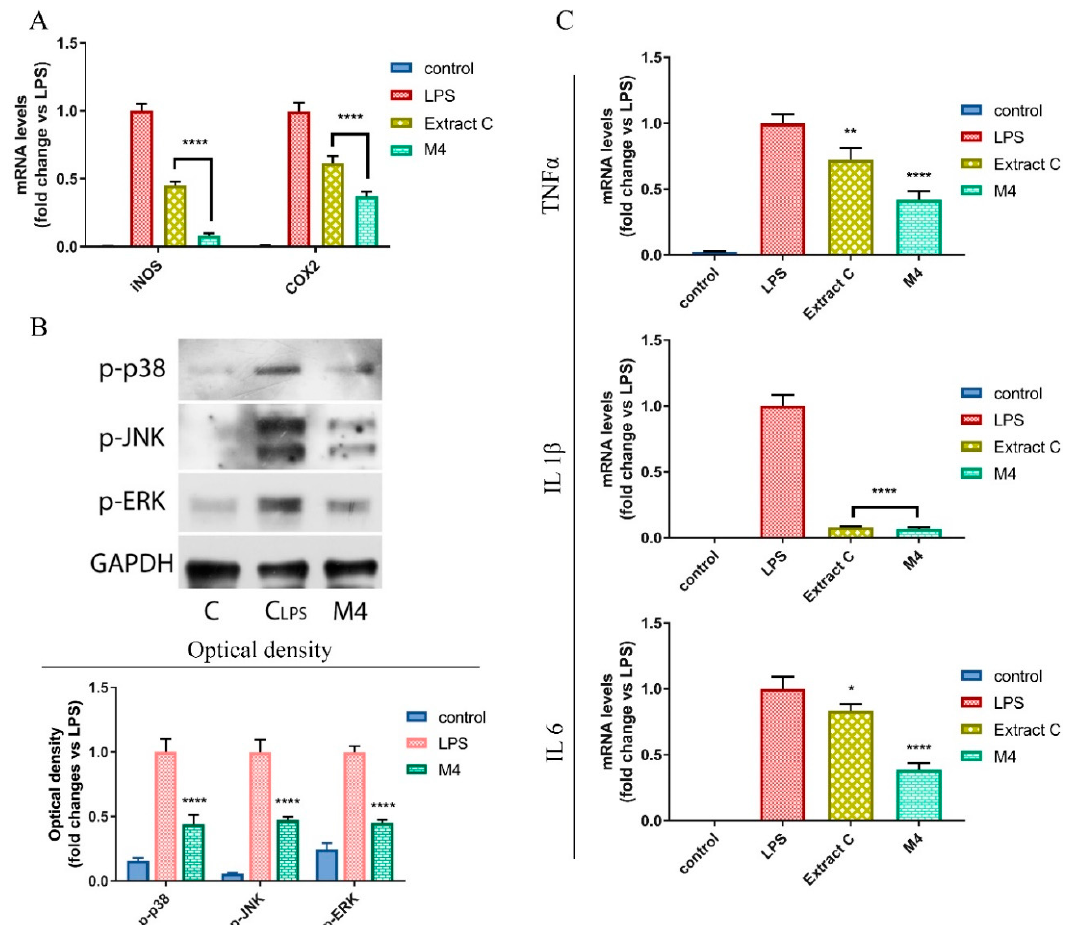
Figure 6. Licoflavanone (M4), as well as the phytocomplex from which it was isolated (extract C), disrupts mitogen-activated protein kinases (MAPK) / NF-kB pathway and modulates pro-inflammatory cytokines in RAW 264.7 cells. ( A ) E ff ects of extract C and M4 (both used at their IC 50 values) on inducible nitroxide synthase (iNOS) and cyclooxygenase 2 (COX2) mRNA levels. ( B ) Immunoblotting analysis of phosphorylated MAPKs (p-p38, p-JNK and p-ERK) and relative quantification of expression levels. Glyceraldehyde 3-phosphate dehydrogenase (GAPDH) was used as loading control ( C ) E ff ects of treatments on pro-inflammatory cytokines (Tumor Necrosis Factor alpha (TNF α ), Interleukin-1 beta (IL 1 β ) and Interleukin-6 (IL 6)) mRNA levels. Treatment conditions for the di ff erent experiments are reported in the Methods (Sections 2.11 and 2.12). Values represent mean ± S.D. of three independent experiments, each one performed with triplicate samples. * p < 0.05; ** p < 0.01; **** p <